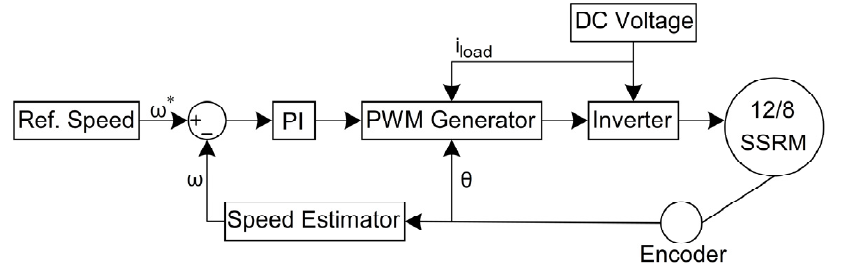
Figure 10. The control scheme for the 12/8 SRM with CW and segmental rotor. Notes: ω * is rotor’s reference angular velocity; ω denotes angular velocity; θ represents rotor position; i load means the motor current with load.